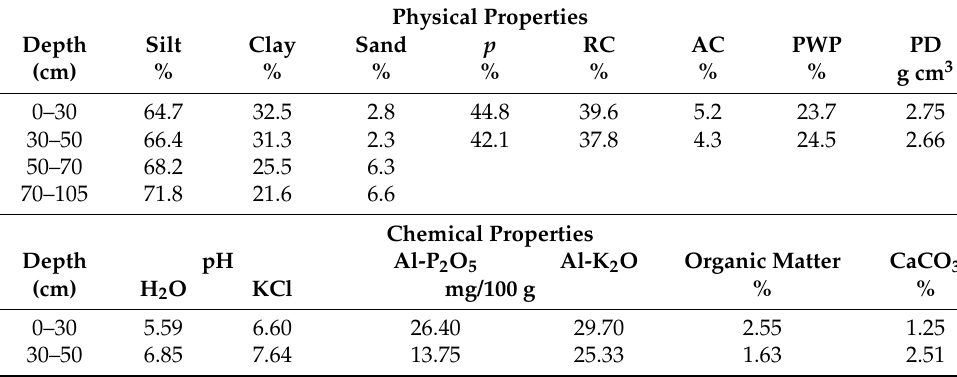
Table 1. Physical and chemical properties of the soil.